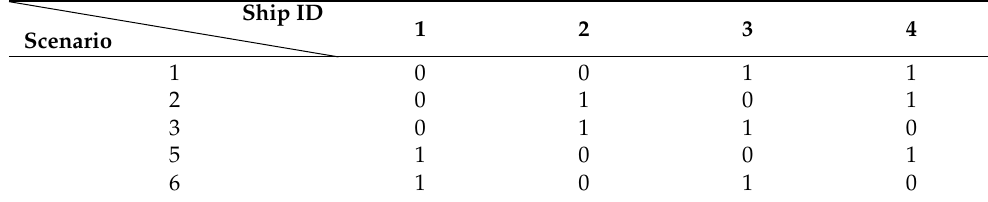
Table 9. Example 2—results after Stage 2.